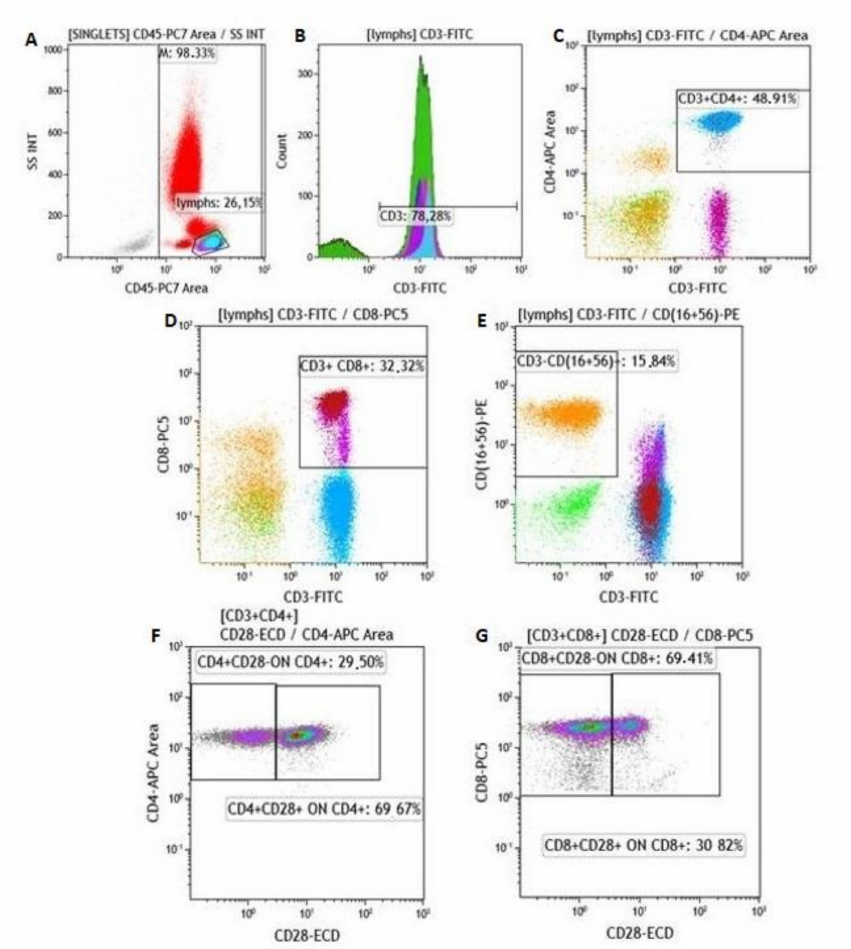
Figure 5. Description of gating process. ( A ) Gating of lymphocytes and identification of ( B ) CD3+, ( C ) CD3+CD4+, ( D ) CD3+CD8+, ( E ) CD3–CD(16+56)+ cells, CD28– cells on CD4+ population, ( F ) CD4+CD28null cells and CD28– cells in CD8+ population, ( G ) CD8+CD28null cells. Absolute numbers and percentages of lymphocytes (CD45+ cells), CD3+CD4+, CD3+CD8+, NK cells, Tregs, CD4+CD28+, CD4+CD28null, CD8+CD28+, and CD8+CD28null cells were esti-